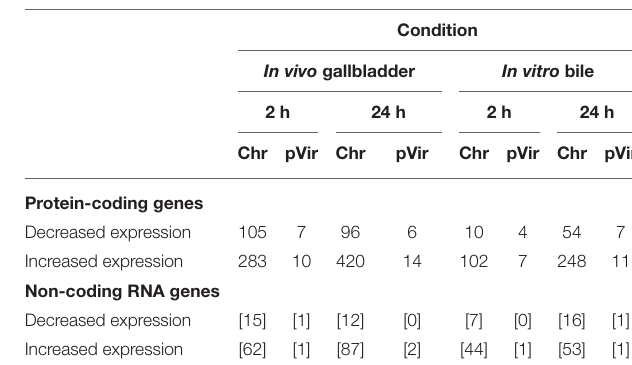
TABLE 1 | Summary of the differences in numbers of genes with increased and decreased expression under either in vivo or in vitro bile exposure when compared to unexposed IA3902 at both 2 and 24